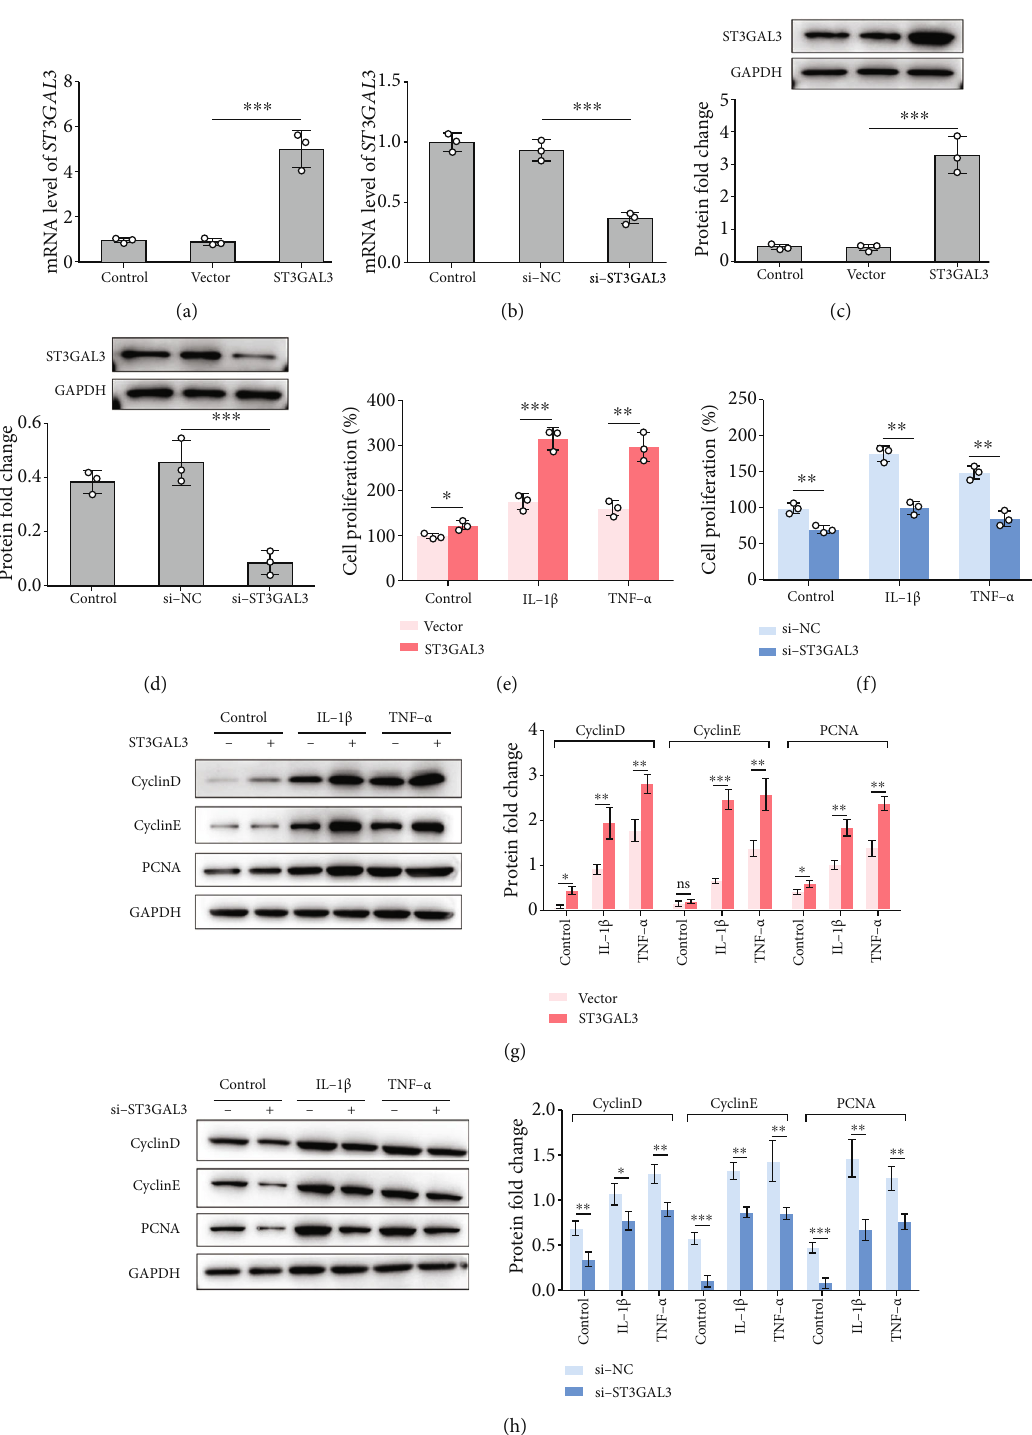
Figure 2: ST3GAL3 promoted the proliferation of MH7A cells. (a, b) After MH7A cells were transfected with ST3GAL3 overexpression plasmid or ST3GAL3 siRNA, qRT-PCR was performed to show the gene expression of ST3GAL3 . (c, d) Western blotting analysis was performed to show the protein expression of ST3GAL3. (e, f) MTT assay showed that ST3GAL3 overexpression promoted cell proliferation, while si-ST3GAL3 inhibited cell proliferation. (g, h) Western blotting analysis showed that the overexpression of ST3GAL3 promoted the protein expression of cyclinD, cyclinE, and PCNA, while si-ST3GAL3 inhibited the expression of those proteins. n = 3 . ∗ p < 0 : 05 , ∗∗ p < 0 : 01 , and ∗∗∗ p < 0 : 001 compared with the indicated